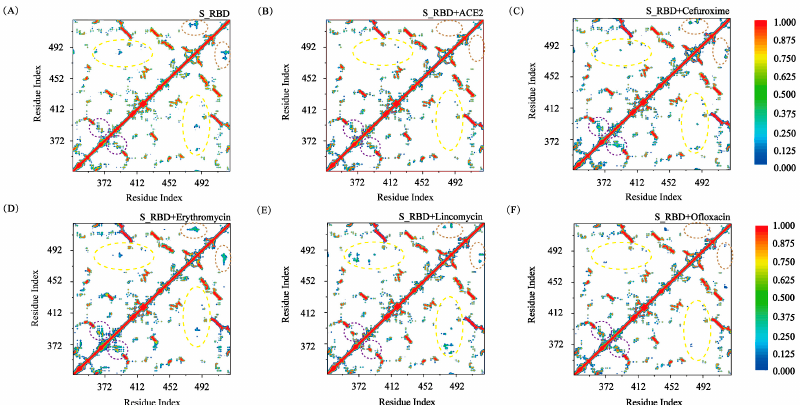
Figure 3. The interactions between the residues of S_RBD. The residue-residue contact probability maps for the S_RBD. ( A ) for the S_RBD system, ( B – F ) for the S_RBD in the presence of ACE2, Cefuroxime, Erythromycin, Lincomycin and Ofloxacin system, respectively.